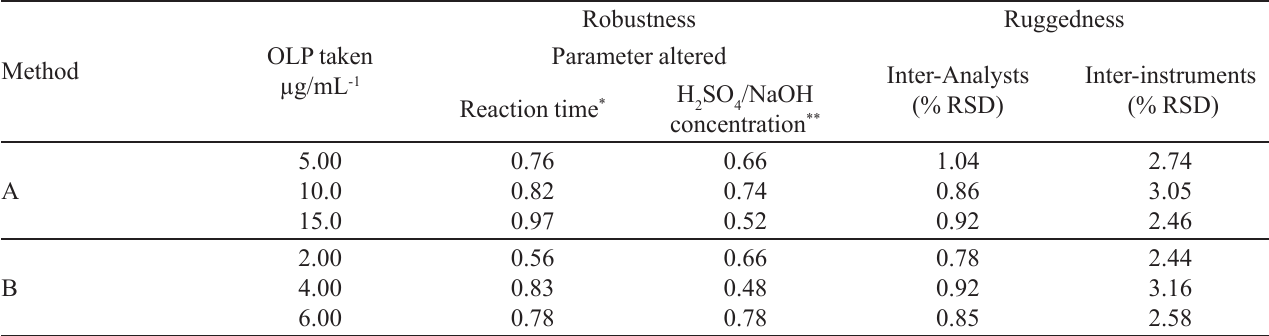
TABLE IV - Method robustness and ruggedness expressed as intermediate precision (% RSD)